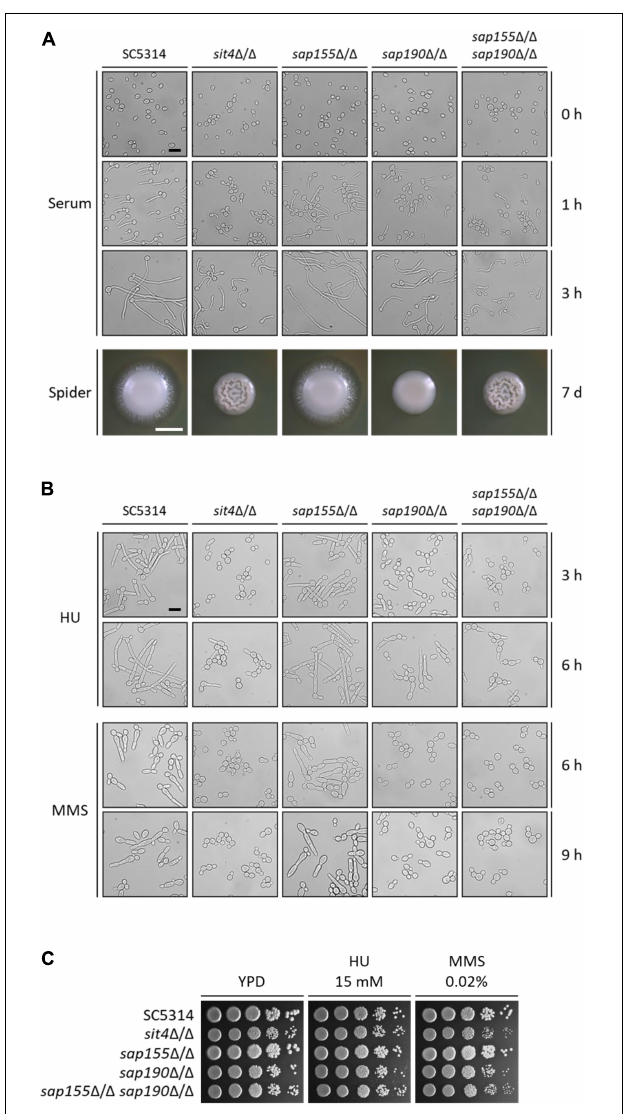
FIGURE 4 | The morphogenesis of sit4 (cid:49) / (cid:49) , sap155 (cid:49) / (cid:49) , sap190 (cid:49) / (cid:49) , and sap155 (cid:49) / (cid:49) sap190 (cid:49) / (cid:49) mutants. (A) Late-log phase yeast cells of SC5314, sit4 (cid:49) / (cid:49) , sap155 (cid:49) / (cid:49) , sap190 (cid:49) / (cid:49) , and sap155 (cid:49) / (cid:49) sap190 (cid:49) / (cid:49) strains were re-inoculated at 1:20 dilution into fresh YPD medium containing 10% serum and incubated at 37 ◦ C with shaking at 200 rpm. Photos were taken at the indicated times. Size bars = 16 µ m. Colony morphology of the same strains grown on Spider plates at 30 ◦ C for 2 or 7 days, respectively. Size bars = 1 mm. (B) Late-log phase yeast cells of the same strains as described in (A) were re-inoculated at 1:20 dilution into fresh YPD medium containing 15 mM HU or 0.02% MMS and incubated at 30 ◦ C with shaking at 200 rpm. Photos were taken at the indicated times. Size bars = 16 µ m. (C) Log-phase yeast cells of the same strains as described in (A) were serially diluted 10-fold and spotted onto YPD plates supplemented with 15 mM hydroxyurea (HU) or 0.02% methyl methanesulfonate (MMS). The YPD plates were incubated at 30 ◦ C for 48 h.